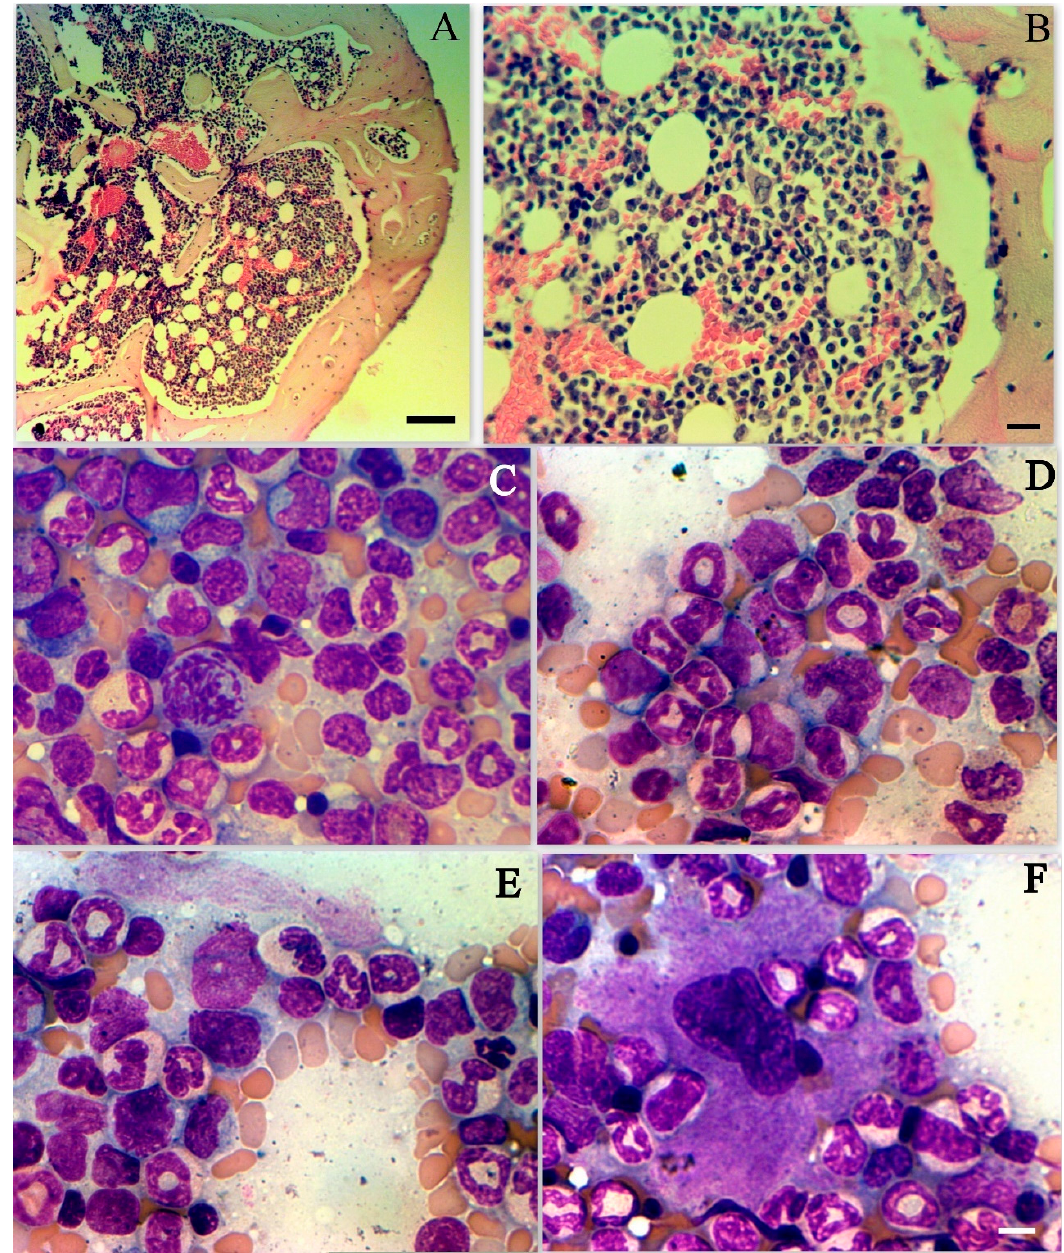
Figure 6. SARS-CoV-2 infection in hamster bone marrow. ( A ) Preserved structure of BM in SARS- CoV-2 infected hamsters bone marrow structure preserved (3rd dpi); HE staining; scale bar 250 µ m. ( B ) Normal cellularity in BM in SARS-CoV-2 infected hamsters (3rd dpi); HE staining; scale bar 100 µ m. ( C ) Decreased number of nucleated erythroid cells on 5th dpi in BM. Giemsa staining; Present mitosis; scale bar 10 µ m. ( D ) Decreased number of nucleated erythroid cells on 7th dpi in BM. Giemsa staining; scale bar 10 µ m. ( E ) Decreased number of nucleated erythroid cells on 8th dpi in BM. Giemsa staining; scale bar 10 µ m. ( F ) Preserved megakaryocyte on 7th dpi in BM. Giemsa staining; scale bar for ( A – F ) 10 µ